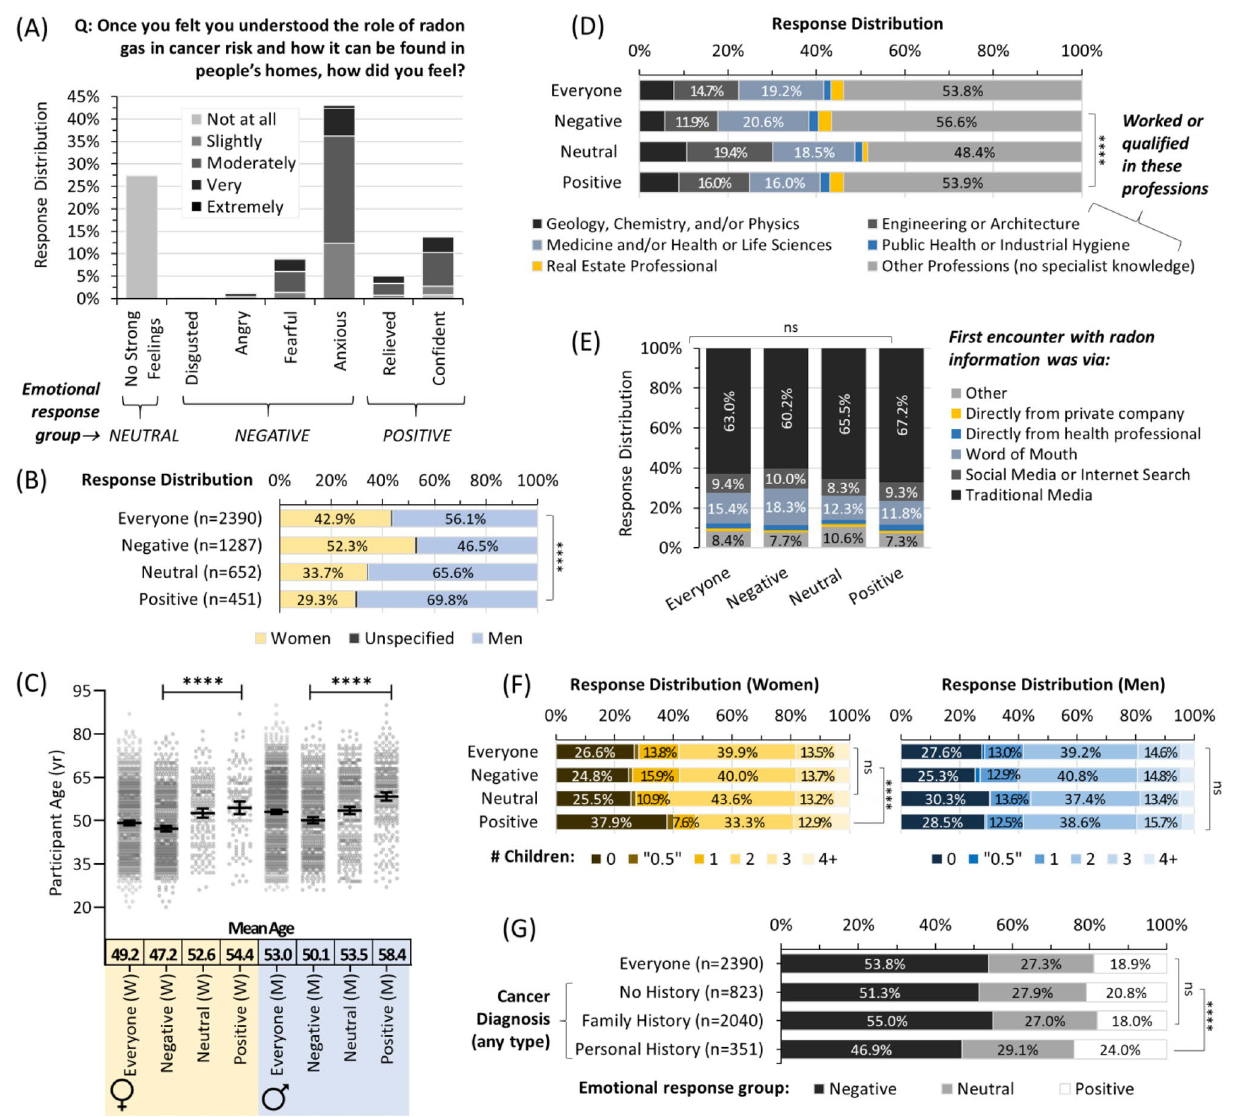
Figure 3. Emotional reactions to radon awareness vary by personal demographics, but not the first encounter. Panel ( A ) Overall distribution and Likert scale intensity of emotional responses to gaining awareness of radon health effects and how it can be found in homes. Panel ( B ) Emotional response distributions from ( A ) as a function of sex. Panel ( C ) Emotional response distributions from ( A ) as a function of sex and age. Mean Age refers to a geometric mean ± CI95%. Panel ( D ) Emotional response distributions from ( A ) as a function of status (worked or qualified) in professions with or without the potential for a specialist on radon. Panel ( E ) Emotional response distributions from ( A ) as a function of their first encounter with radon awareness information. Panel ( F ) Emotional response distributions from ( A ) for parental status of women (left, yellow) and men (right, blue). Panel ( G ) Emotional response distributions from ( A ) as a function of experience with a cancer (of any type) diagnosis. Statistical comparisons are Mann–Whitney pairwise nonparametric t-tests of comparisons for scatter plot data or 1-way ANOVA for all other data. **** = p < 0.0001; ns = p > 0.05. Figures were prepared using Excel and GraphPad Prism 9.1.1 (225) (www. graph pad.